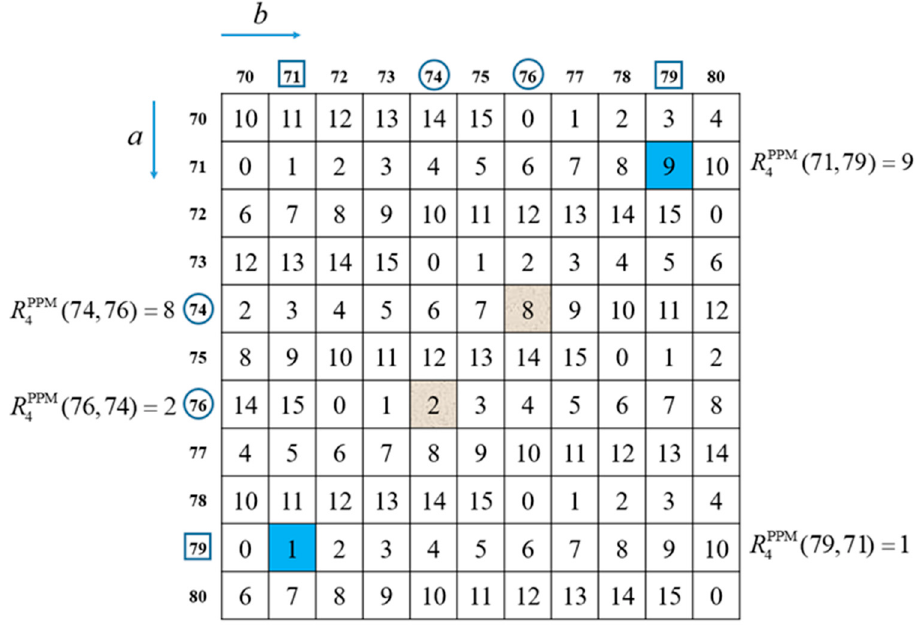
Figure 2. Partial reference table of PPM